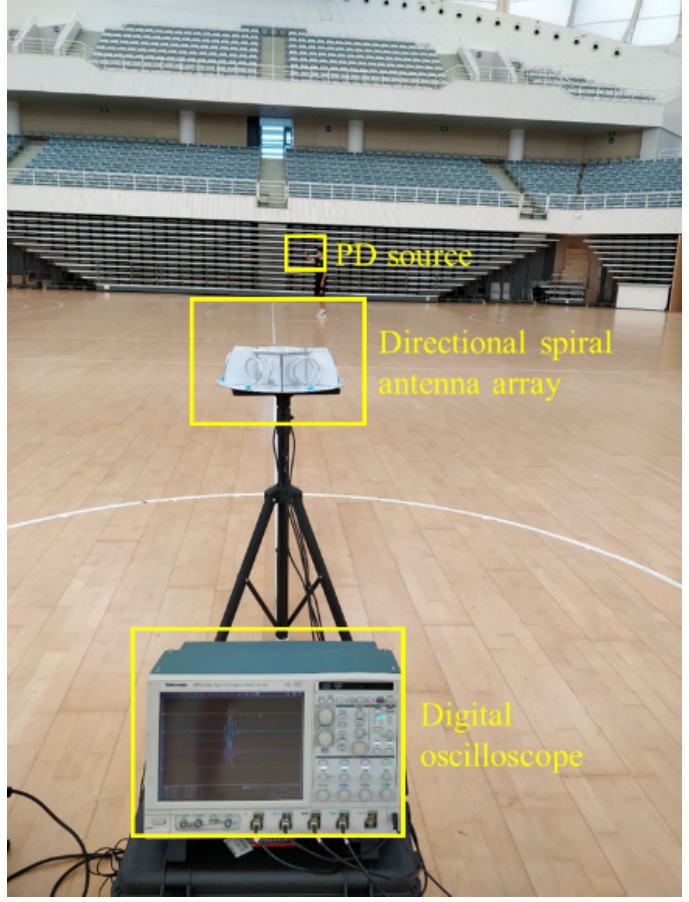
Figure 12. Experimental